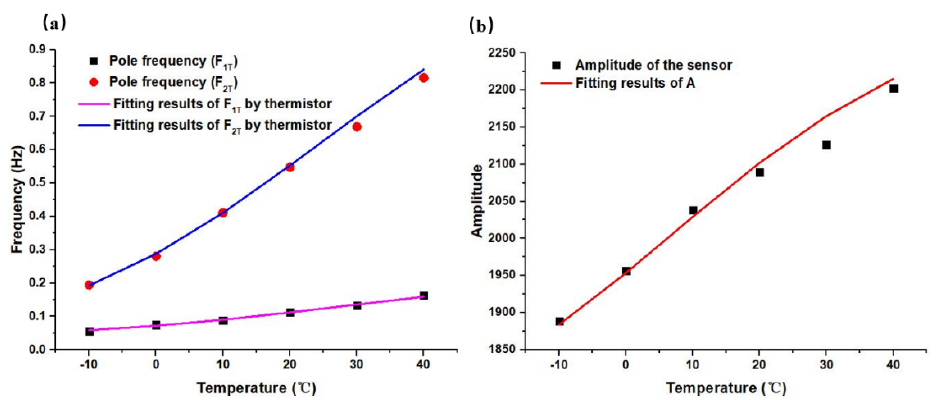
Figure 10. ( a ) Fitting results of pole frequencies. ( b ) Fitting results of sensitivity coefficient.